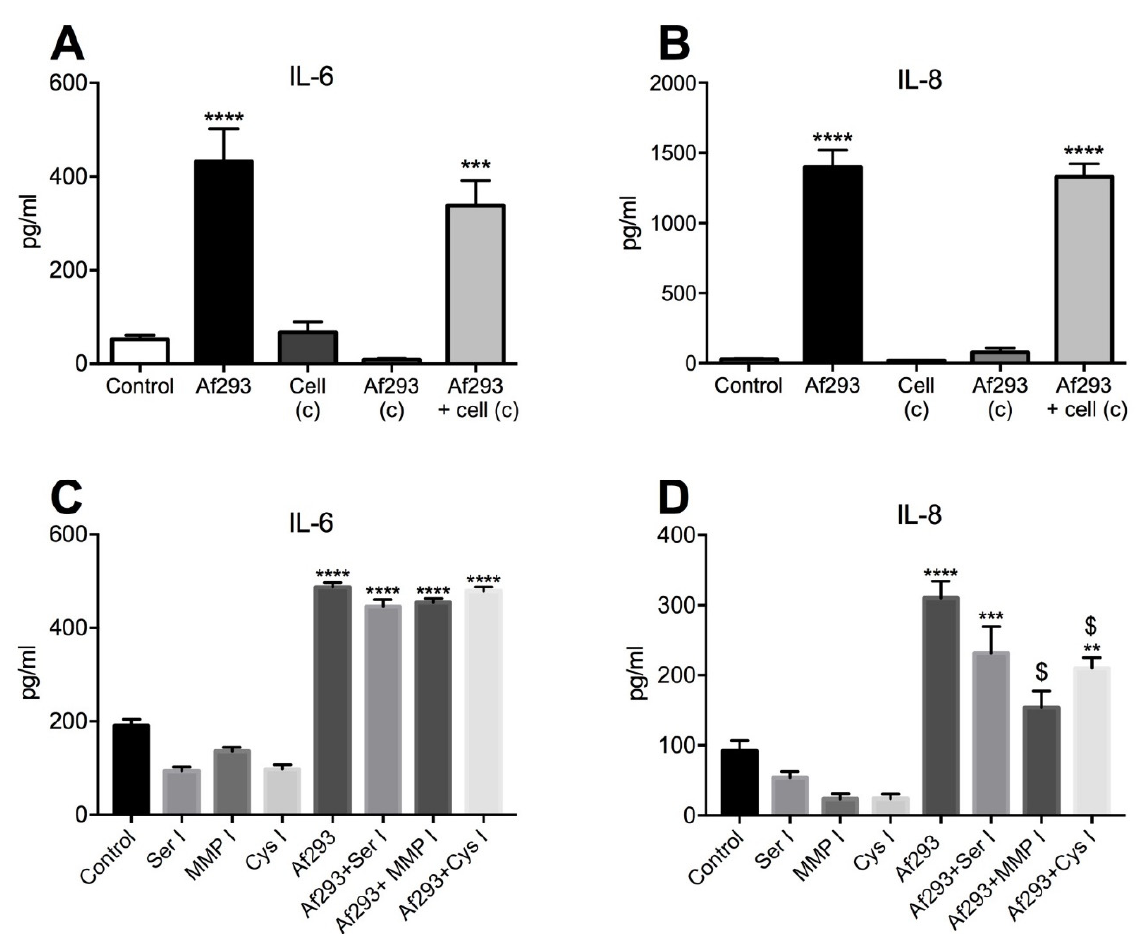
Figure 4. Fungal proteases play a role in Af293 induced IL-8 production. Conditioned media from germinating conidia cultured alone (Af293 c) or from conidia-exposed cells (Af293+cells c) did not induce production of either ( A ) IL-6 or ( B ) IL-8. Protease inhibition had no effect on ( C ) Af293-induced IL-6 production; however, ( D ) MMP inhibition (MMP I) and cysteine protease inhibition (Cys I) significantly reduced IL-8 levels. Data represent mean +/ − SEM; one-way ANOVA with Bonferroni multiple comparison test. **** p < 0.0001; *** p < 0.001, ** p < 0.01 compared with unexposed control and $ indicates p < 0.0001 for MMP I and p < 0.02 for Cys I compared with Af293-exposed cells.